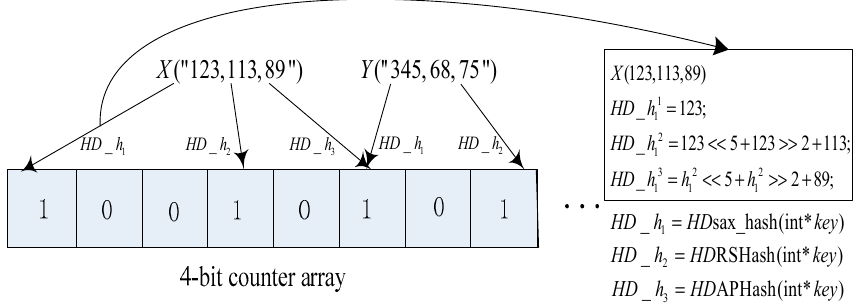
Figure 2. Structure of high dimension vector Bloom filter.